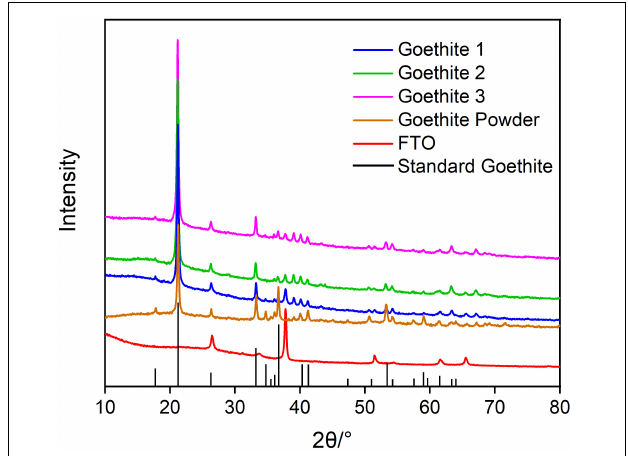
FIGURE 1 | X-ray diffraction patterns of synthetic